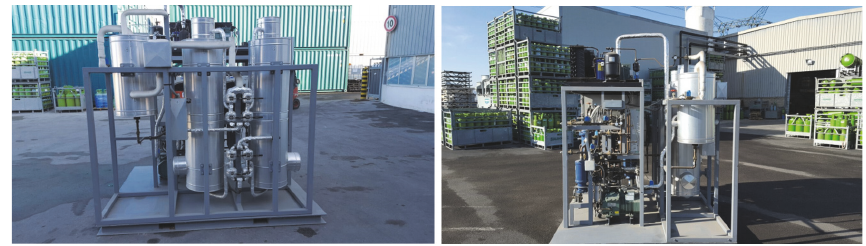
Figure 3: Front and lateral view of the integrated plant prototype.